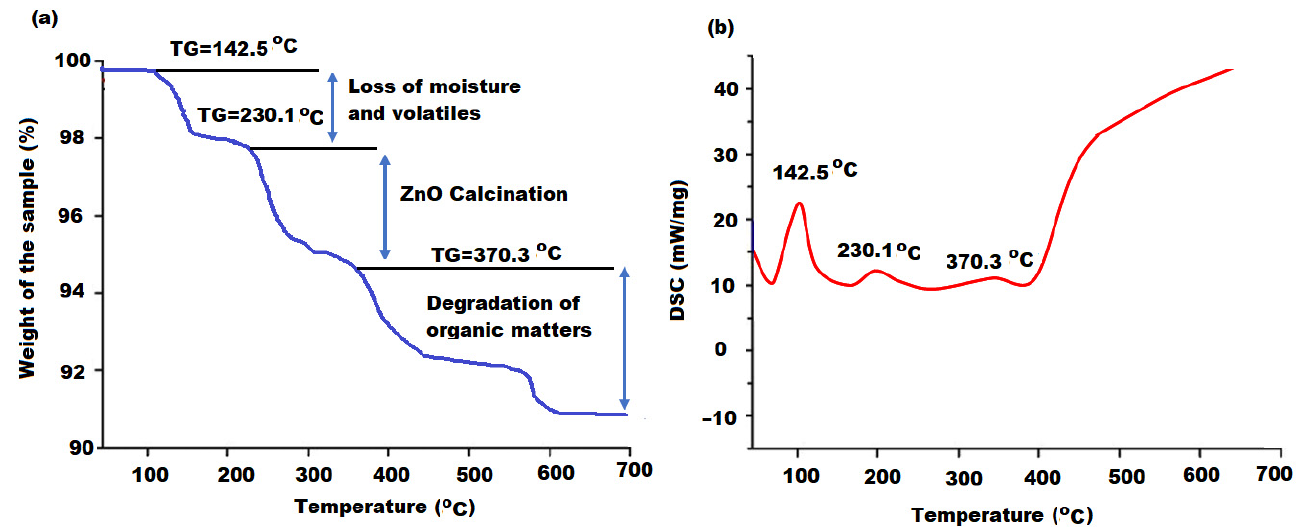
Figure 6. ( a ) Thermogram of ZnONPs at the temperature range 80-700 °C and ( b ) diffraction scan- ning calorimetry graph of ZnONPs synthesized with oat biomass